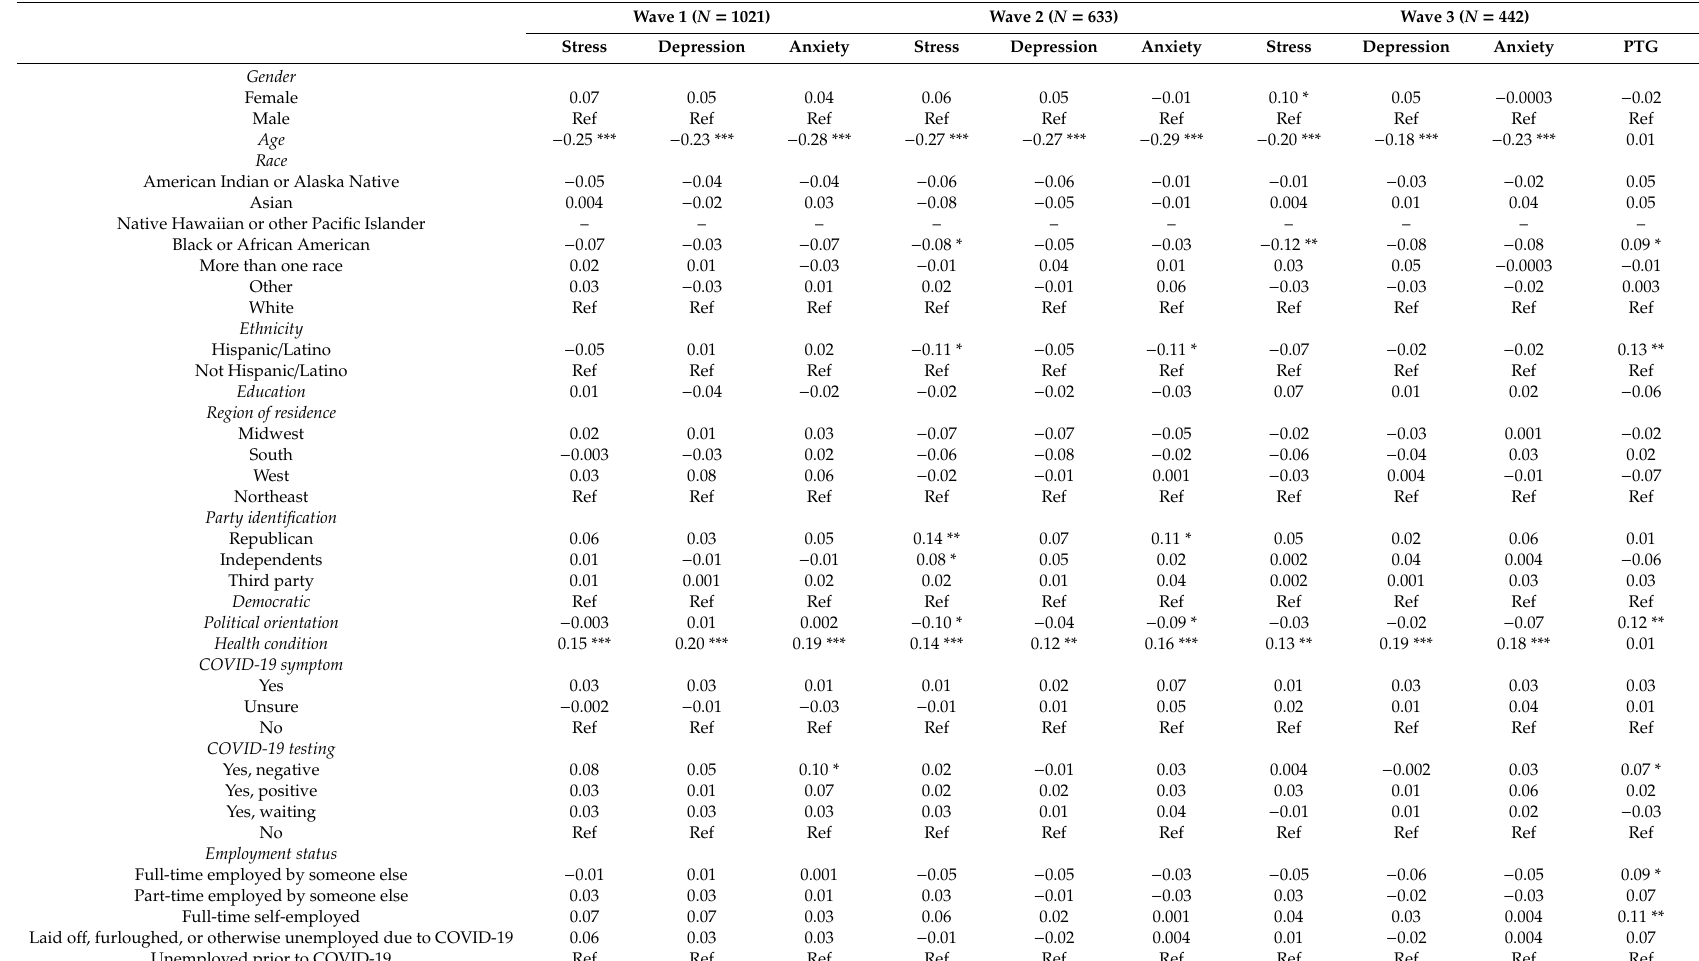
Table 6. Multiple Regression of Mental Health Outcomes on Demographic